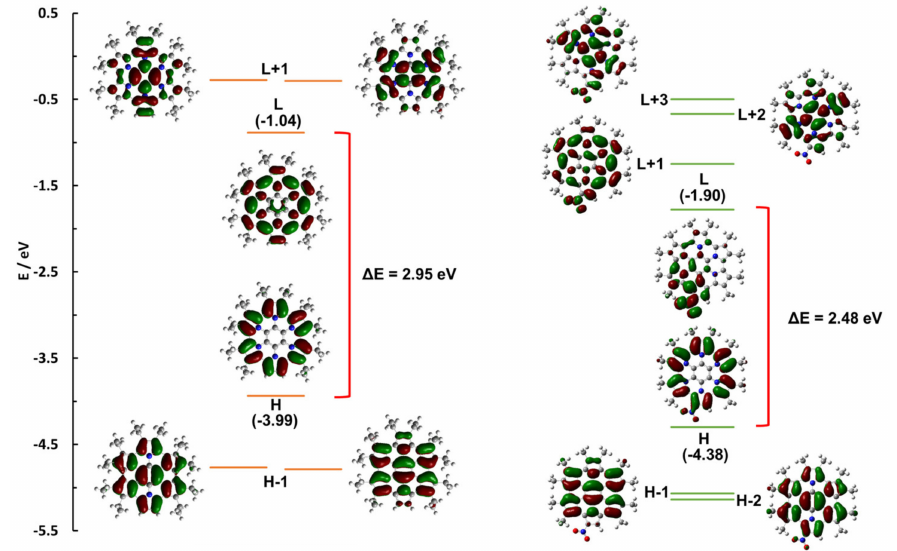
Figure3. MolecularorbitaldiagramsofDMHPHACs 1b and 2b calculatedattheB3LYP /